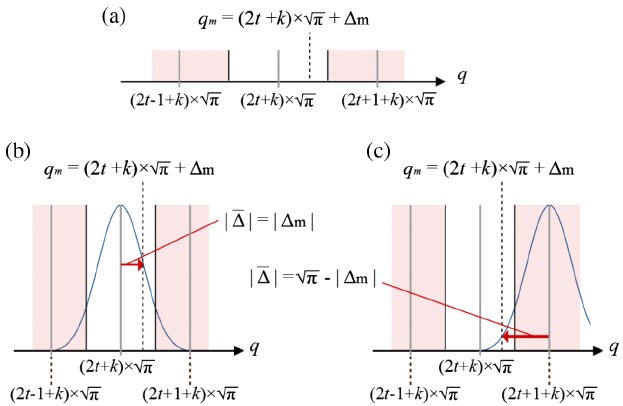
FIG. 1. Introduction of a likelihood function. (a) Measurement outcome and deviation from the peak value in q quadrature. The dotted line shows the measurement outcome q ffiffiffi p ð t ¼ 0 ; (cid:2) 1 ; (cid:2) 2 ; … ; k ¼ 0 ; 1 Þ , where k is de- ð 2 t þ k Þ π þ Δ m fined as the bit value that minimizes the deviation Δ